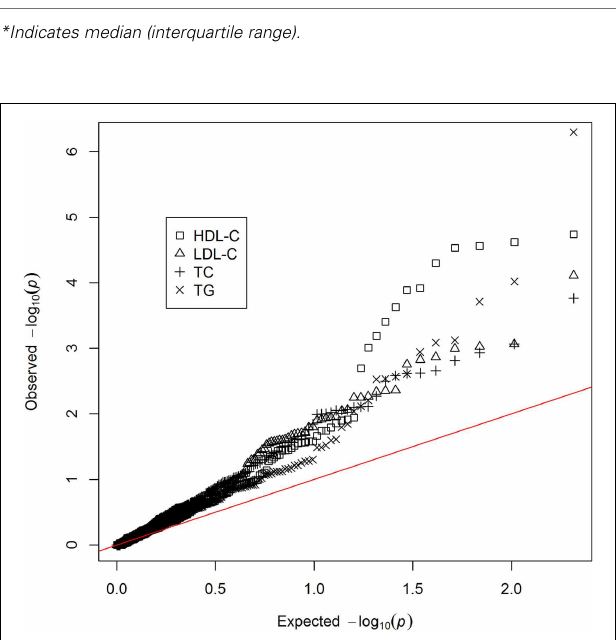
FIGURE 1 | QQ-plot of single marker associations between previously reported genetic risk markers and lipid levels